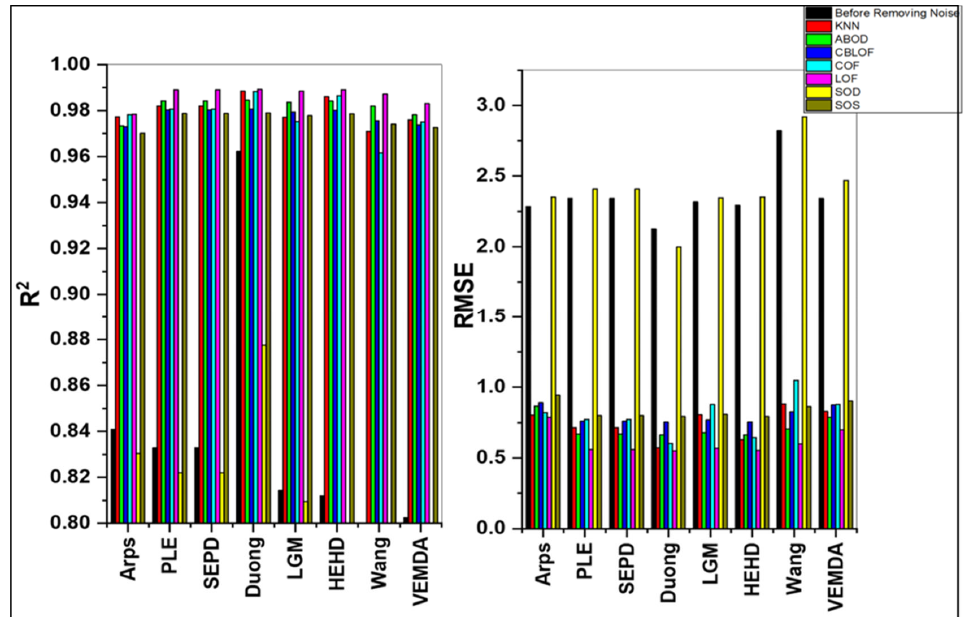
Figure 28. Well_40; R 2 and RMSE after applying 8 DCA models before and after removing the noise using the 7 algorithms.